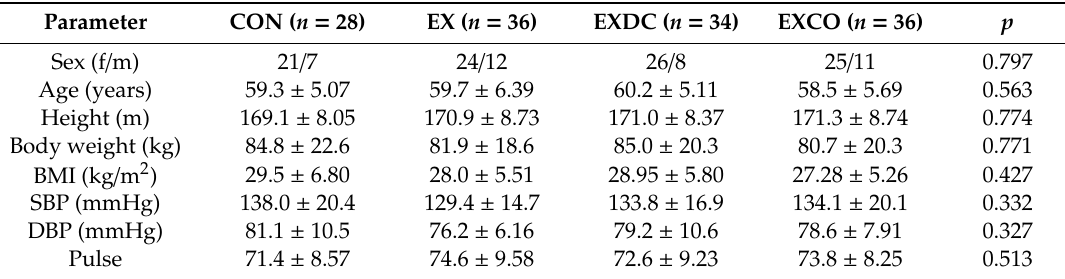
Table 2. Baseline characteristics of all